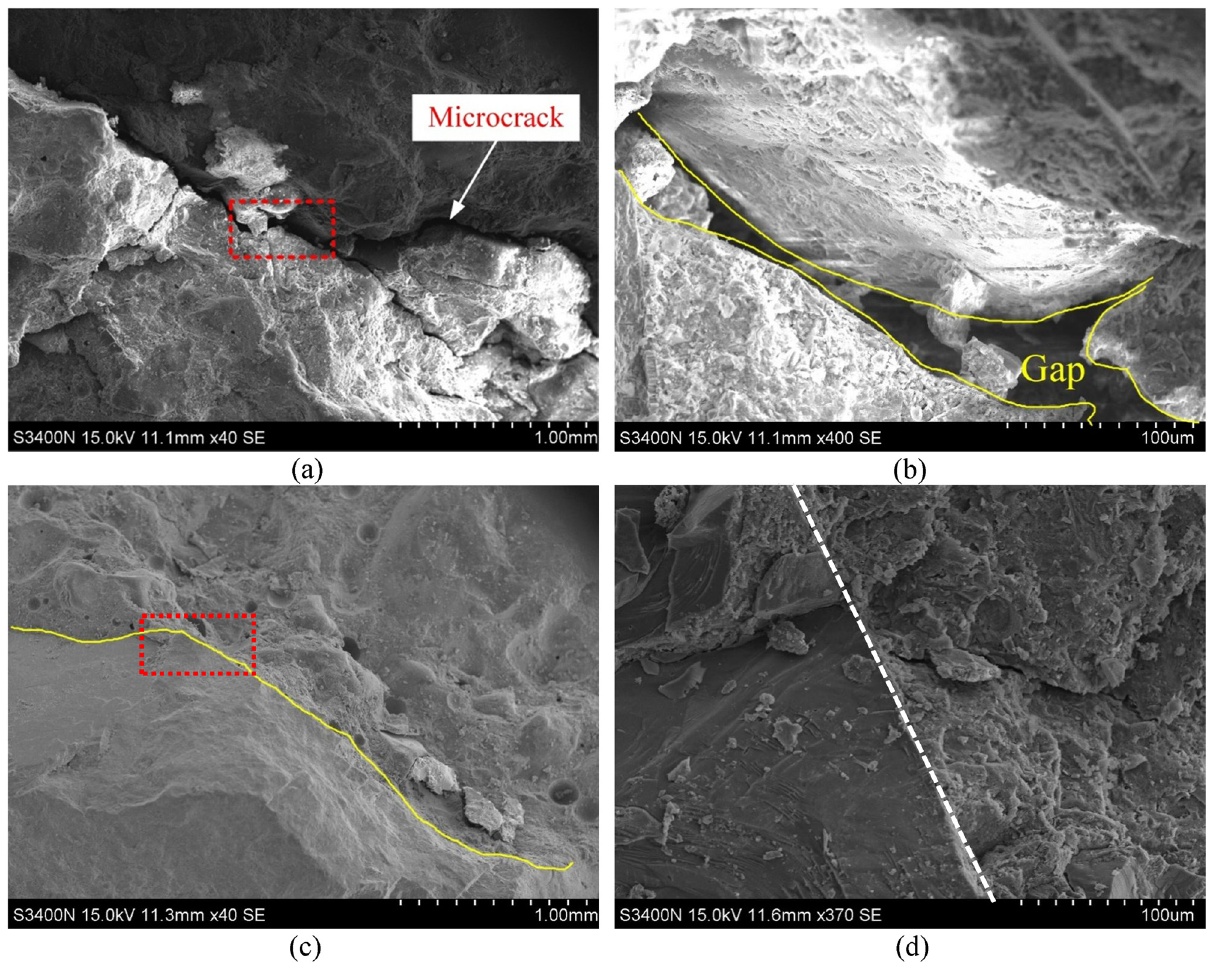
Figure 17: Comparison of microstructures of RAC and SSRAC. ( a ) RAC, ( b ) zoom in ( a ) , ( c ) SSRAC, and ( d ) zoom in of ( c ) .